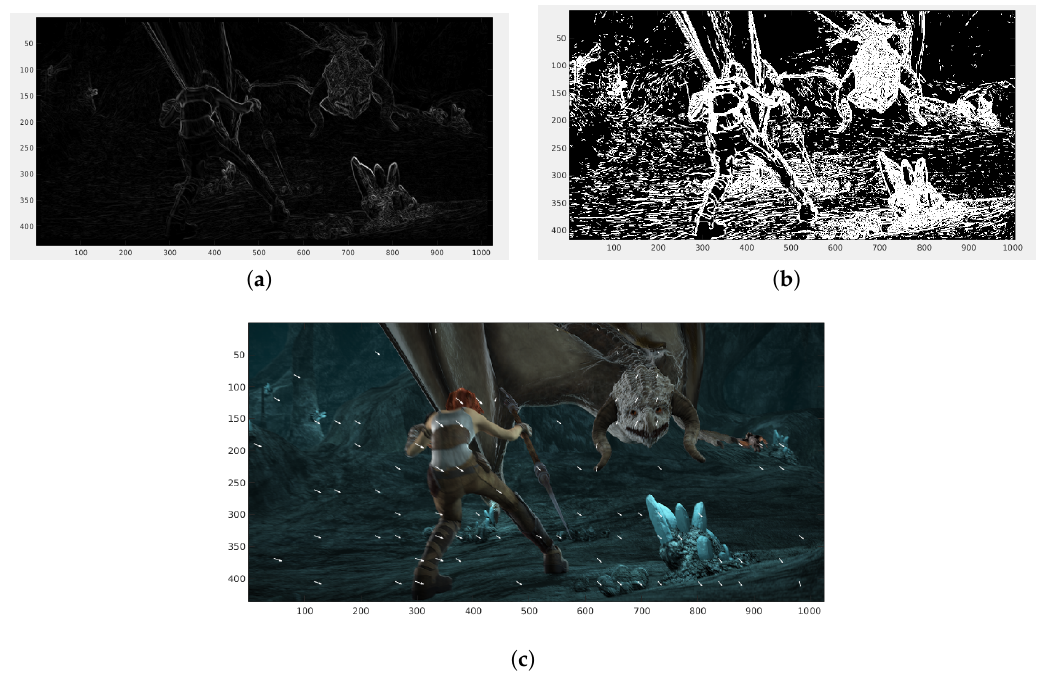
Figure 5. ( a ) Gradient of the reference image. ( b ) Large gradient set. ( c ) Matching result of patches located in the large gradient uniform grid.